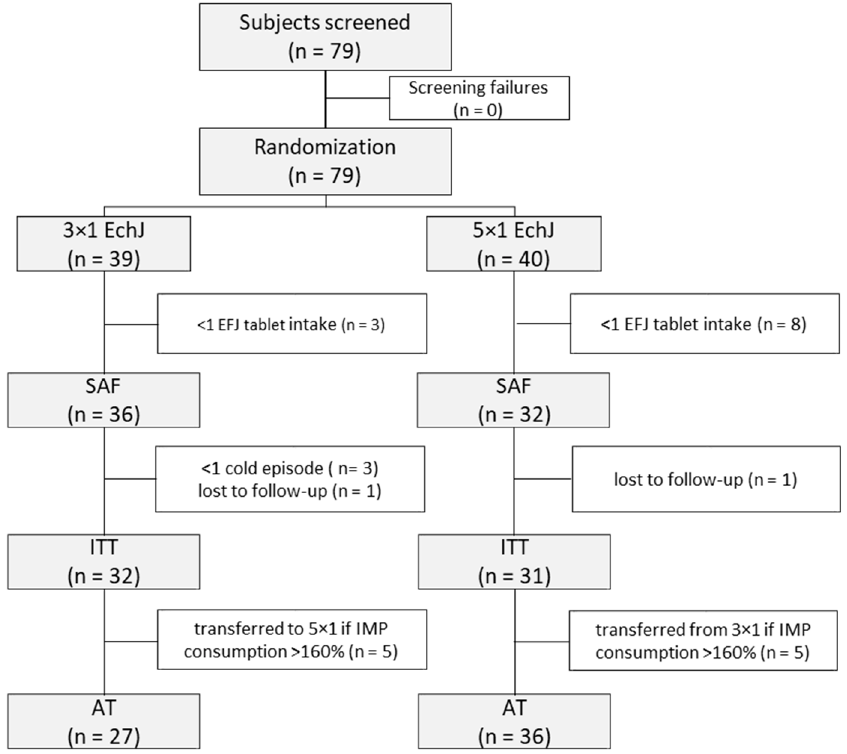
Figure 1. Patient disposition chart. SAF—safety collective; ITT—intention-to-treat collective; AT—as- treated